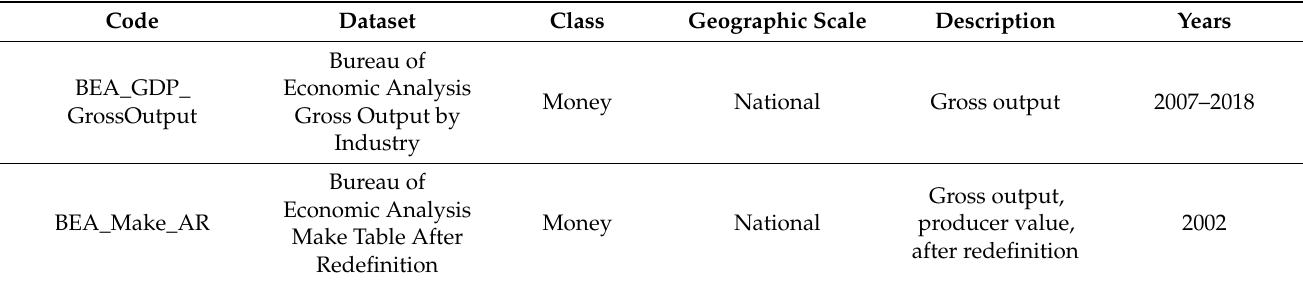
Table 2. Flow-by-activity datasets present in FLOWSA